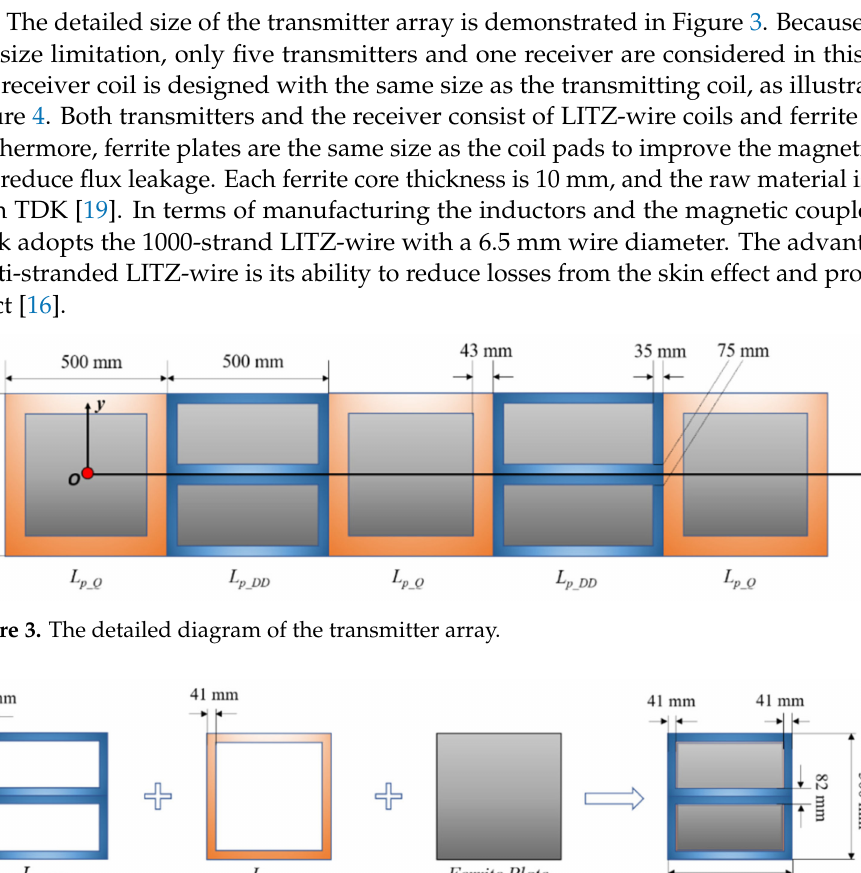
Figure 5. The exact coil connection method from this work is demonstrated in Table 1.